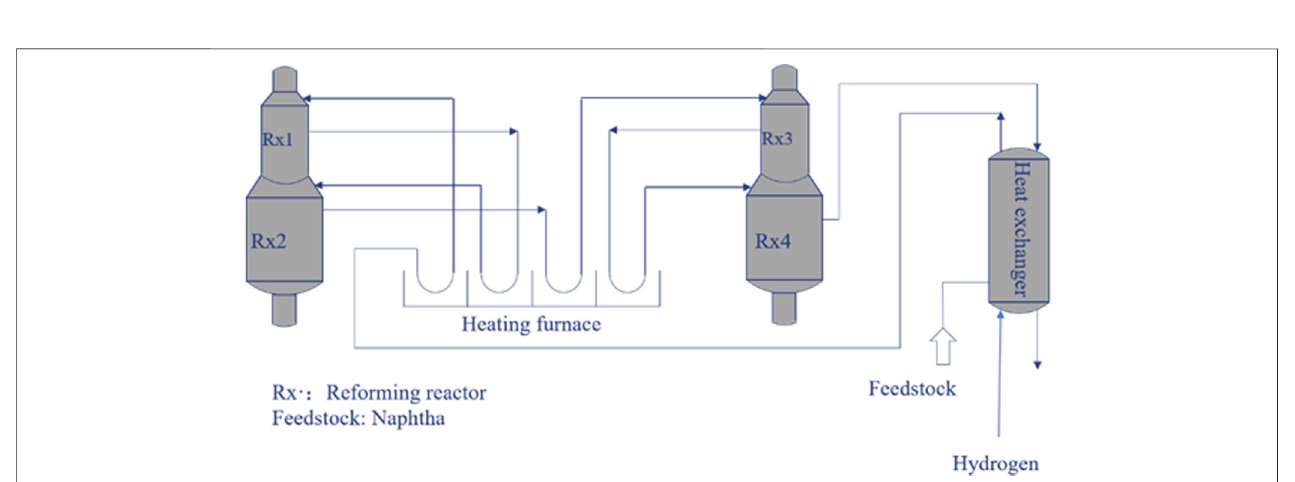
FIGURE 6 | The fl ow chart of the industrial continuous catalytic reforming heat exchange